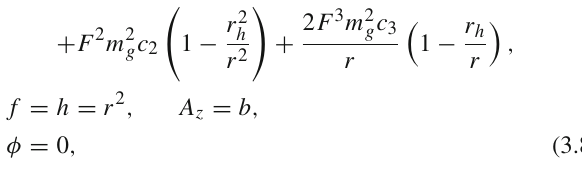
points of the phase transition. Right: the diagonal conductivities as a function of graviton mass. The green line is for the analytical result at M / b = 0, while the red (blue) dashed lines are for numerical results of transverse (longitudinal) conductivities at M / b =